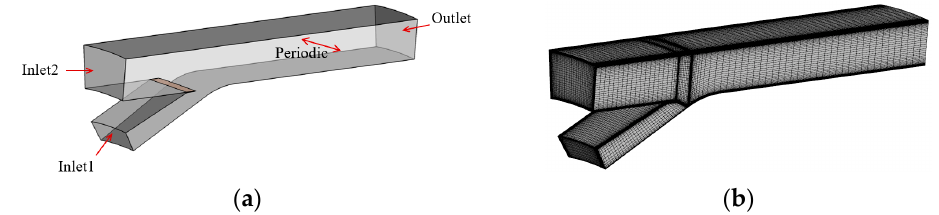
Figure 2. Schematic and mesh of the VABI model: ( a ) boundary conditions; ( b ) simulation mesh.